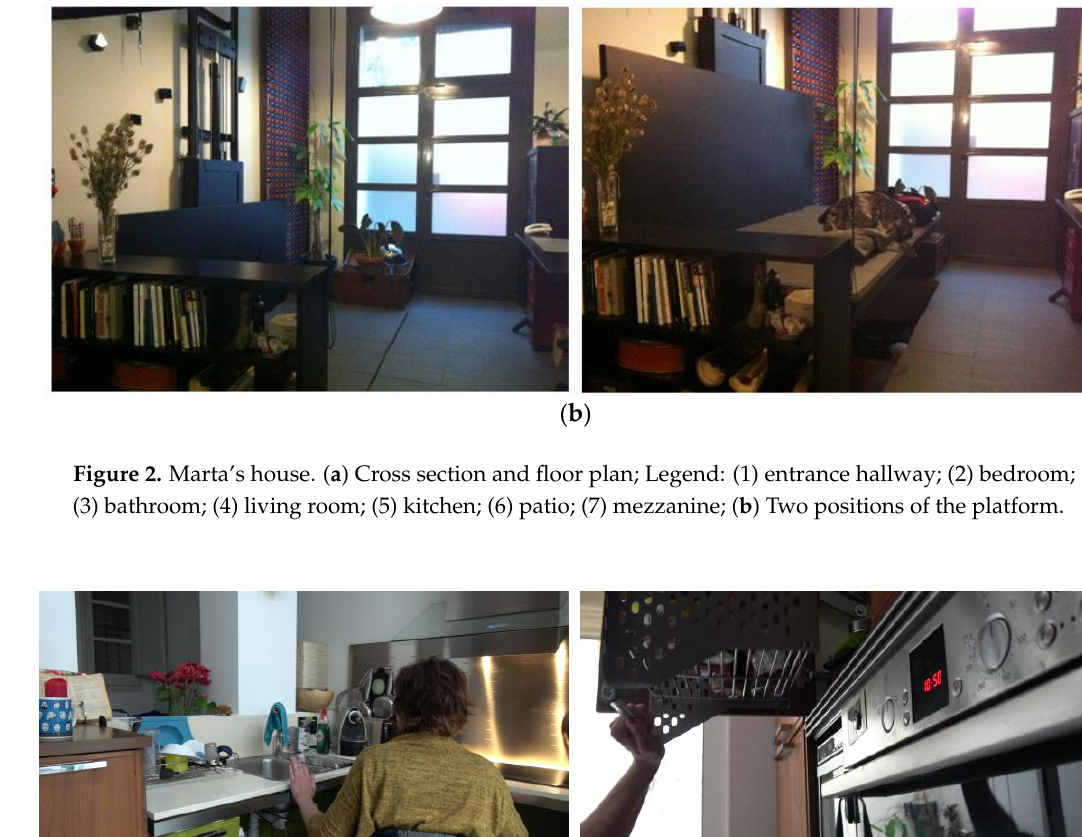
Figure 3. Marta using her kitchen.